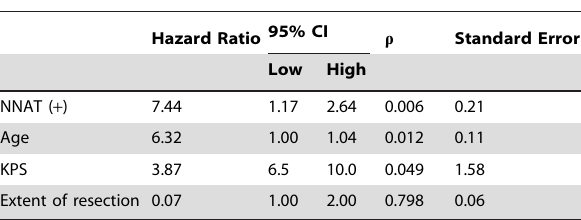
Table 2. Cox Proportional Hazards